Question: What kind of plot is shown here?
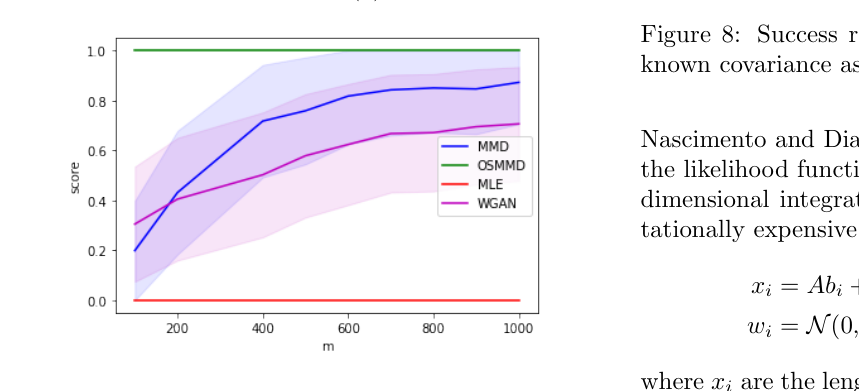
Answer: line